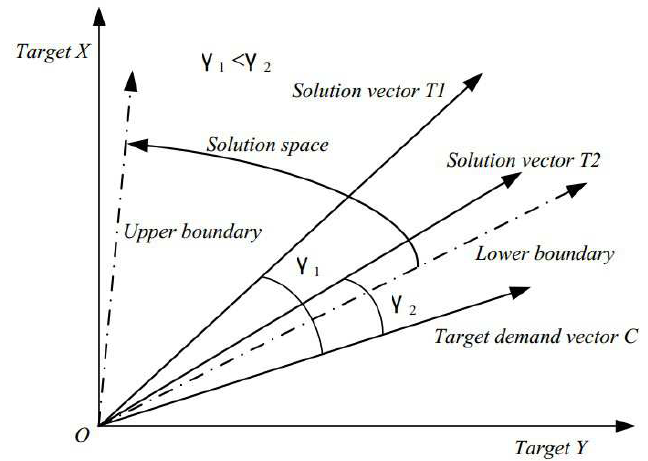
Figure 1. The angle cosine diagram of the solution vector and the target demand